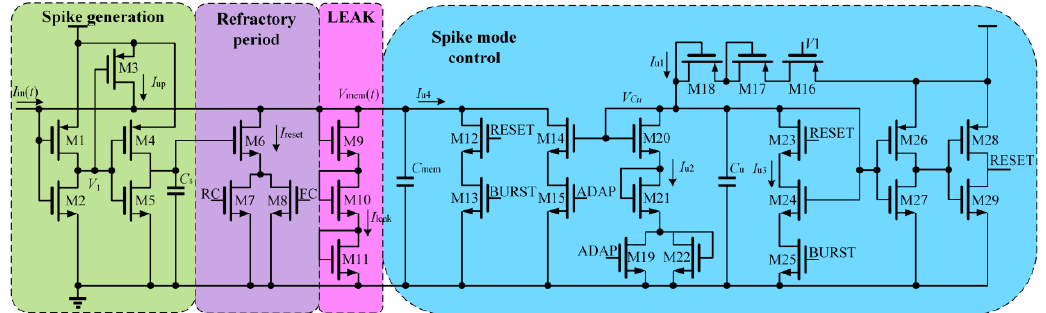
Figure 1. Mixed-signal spike neuron